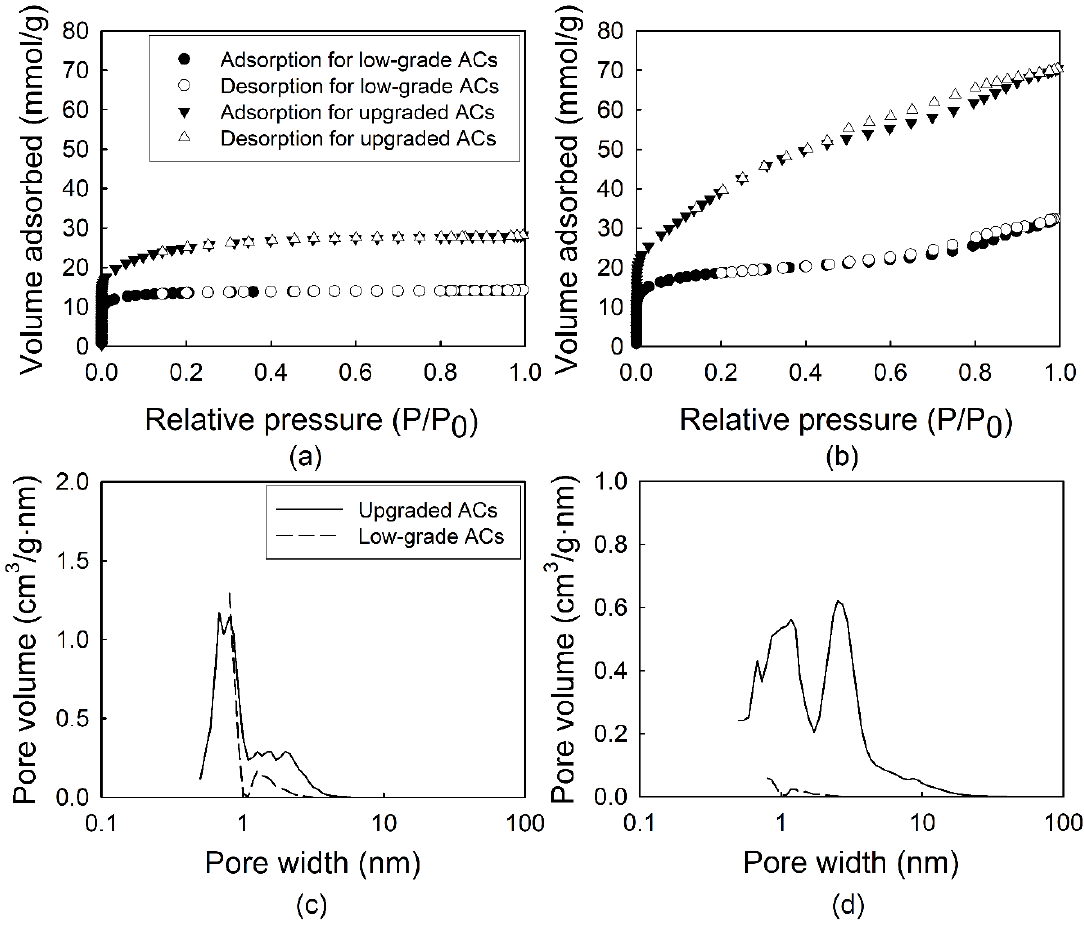
Table 1. Ultimate and proximate analysis of ACs (AC-WR and AC-CR). N.D.: not detected.